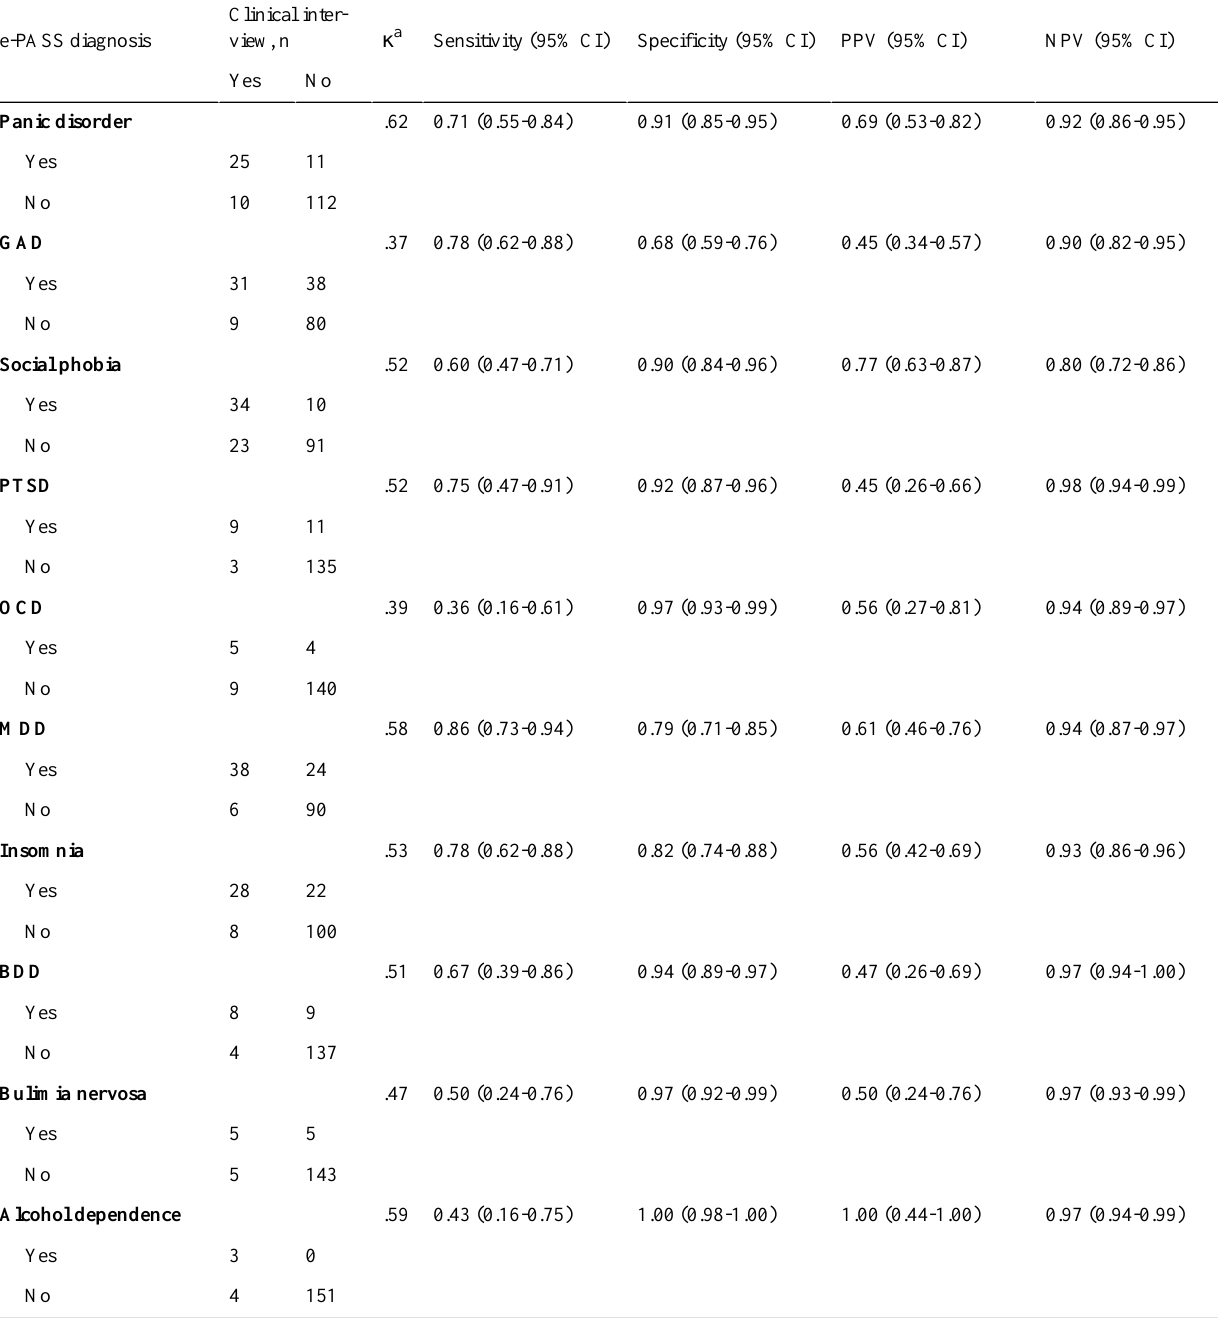
Table 2. Classification statistics of e-PASS clinical diagnoses against clinical interview clinical diagnoses